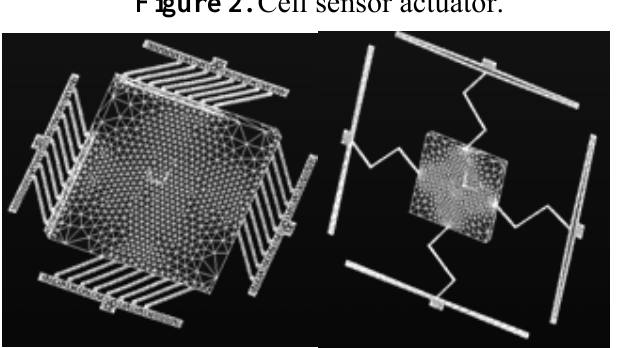
Figure 2. Cell sensor actuator.